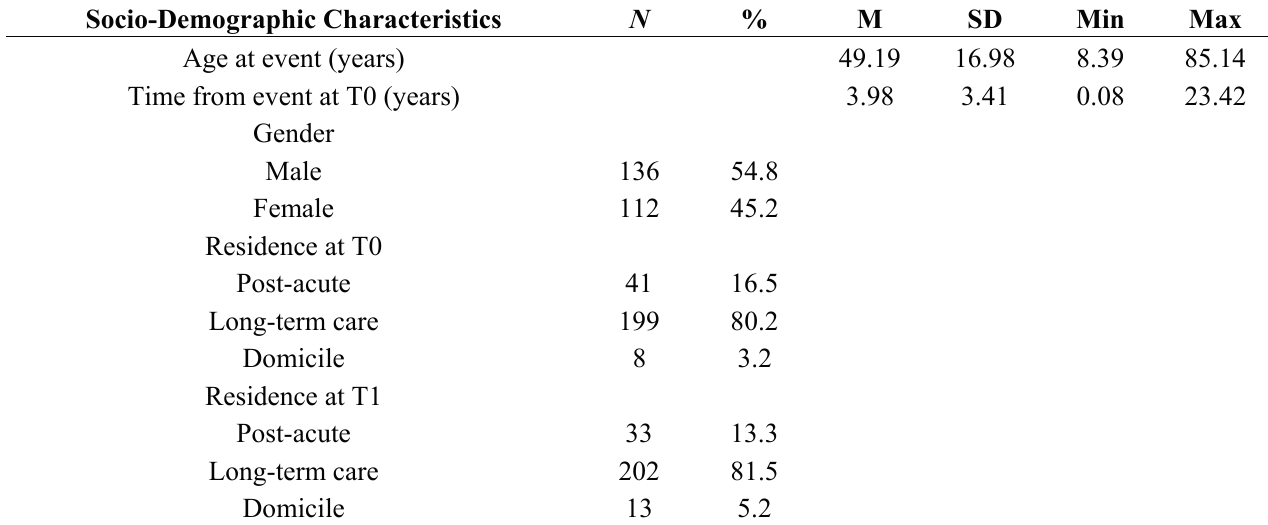
Table 1. Socio-demographic characteristics of the study